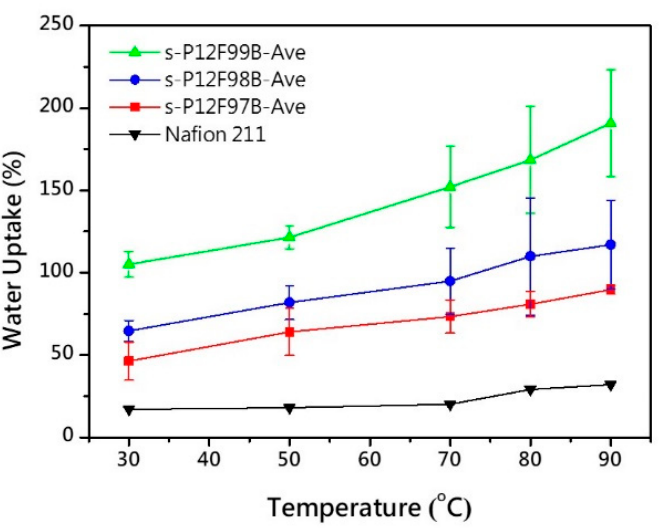
Figure 4. Water uptake as a function of temperature for s-P12FmB-Ave and Nafion 211 membranes. As expected, the WU of the membranes increased with an increase in temperature, IEC, and the number of arms of the phenyl group substituent. The amount of WU of the s-P12FmB series membranes was 24–67% at 30 ◦ C but increased to 74–143% at 80 ◦ C. The highest WU, for the s-P12F99B-2.89 membrane, was twice that of the others at 80 ◦ C. In addition, the slightly higher IEC of the polymer was attributed to the numerous sulfonated active sites and larger free volume on the structure. Within the range of comparable IECs, s-P12F98B-3.00, which had an asymmetric notch in its structure, had the highest initial WU (60%) at low temperatures, and this uptake was greater than that of Nafion 211. The effective WU properties are expected to provide an increase in the proton conductivity of the film. Typically, water is required and generated during the operation of a PEM fuel cell. As a result, membranes with excessive swelling rates may shrink under repeated cell on/off (charge/discharge cycling) operations, resulting in creep and the risk of catalytic layer peeling. In this study, the drawbacks of obtaining films with acceptable swelling rates need to be verified by subsequent rigorous fuel cell lifetime studies. In this system, the hydration number ( λ ), the number of equivalent carriers that participate in carrying ions that are calculated using the experimental value of WU, was equivalent to the number of water molecules per sulfonic acid group. As the result, the s-P12F99B-X series membranes had higher λ (average 27.0) under operating conditions (80 ◦ C; RH, ~99%). This may be because the free space and the distribution of sulfonic acids in the structure are relatively concentrated. On the other hand, the λ of the